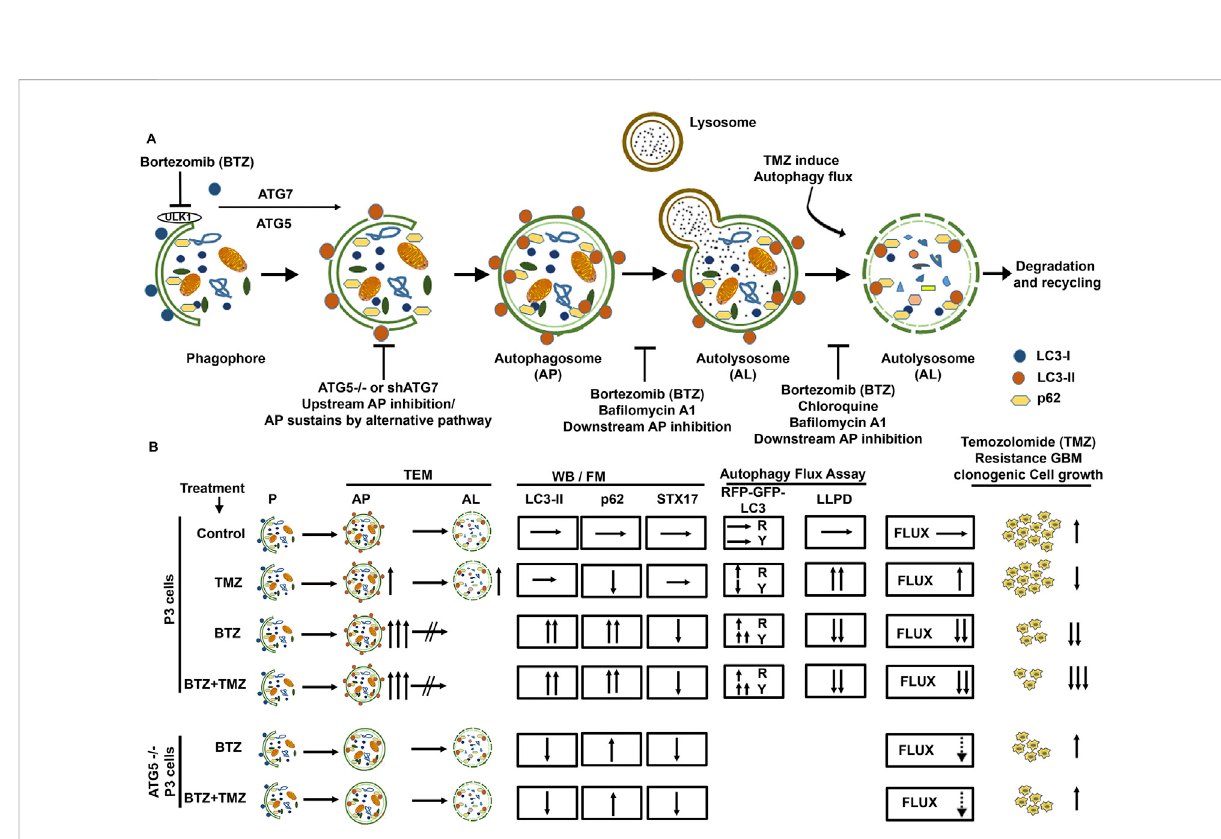
FIGURE 7 Schematic summary of BTZ mediated inhibition of autophagic fl ux and its role in abrogating TMZ resistance in GBM cells. (A) Autophagosome formation requires the conjugation of cytosolic LC3-I to membrane bound LC3A/B-II and the reaction is catalyzed by autophagy related proteins ATG7 and ATG5. p62 (SQSTM1) is bound to the cargo inside the autophagosome. Subsequent fusion of the autophagosomes (AP) to lysosomes results in autolysosome (AL) formation and degradation of the cargo (autophagic fl ux). Macromolecules generated from degraded contents